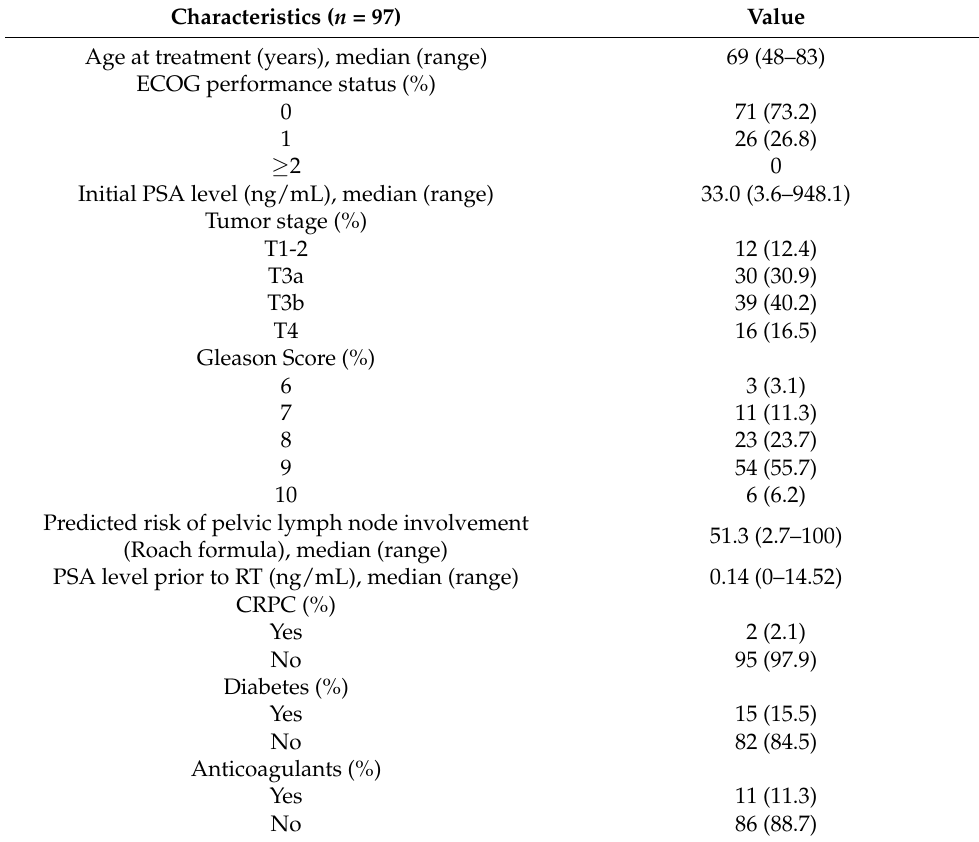
Table 1. Patient characteristics.